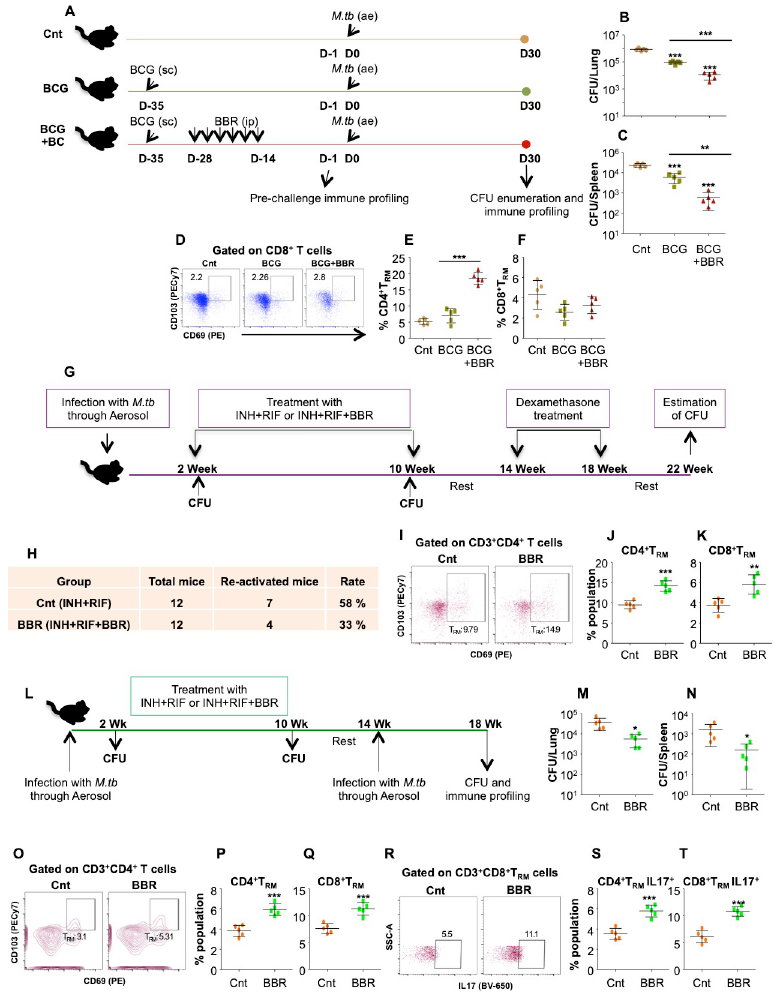
Fig 5. BBR enhances the BCG vaccine efficacy and protects against recurrent TB by inducing T cell resident memory responses in murine model. (A) Schematic representation of vaccine model used in the study. Bacterial load in (B) the lungs and (C) the spleen of infected mice. Ex vivo stimulated lung cells were surface stained with α -CD3 (Pacific Blue), α -CD4 (PerCPCy5.5), α -CD69 (PE), α -CD103 (PECy7), followed by flow cytometry. (D) Representative FACS plots and percentage of (E) CD4 + T RM cells and (F) CD8 + T RM cells in the lung of infected animals. (G) Schematic diagram representing the re-activation model used in this study. (H) Rate of disease relapse with and without BBR treatment. (I) FACS plots representing CD69 and CD103 expressing CD4 + T cells and (J) percentage of CD4 + T RM cells and (K) CD8 + T RM cells in the spleen of infected mice. (L) Diagrammatic representation of re- infection model used in the study. Bacterial burden in (M) the lungs and (N) the spleen of re-infected mice. Ex vivo stimulated single cell suspensions of the lungs were stained with α -CD3 (Pacific Blue), α -CD4 (PerCPCy5.5), α -CD69 (PE), α -CD103 (PECy7), α -CD62L (APC), and α -IL17 (BV650) followed by flow cytometry. (O) Representative FACS plots and the percentage of (P) CD4 + T RM cells and (Q) CD8 + T RM cells in the lungs of re-infected mice. (R-T) Percentage of resident memory T cells producing IL17. Data is representative of two independent experiments. The data values represent mean ± SD (n = 5). � p < 0.05, �� p < 0.005, ��� p <